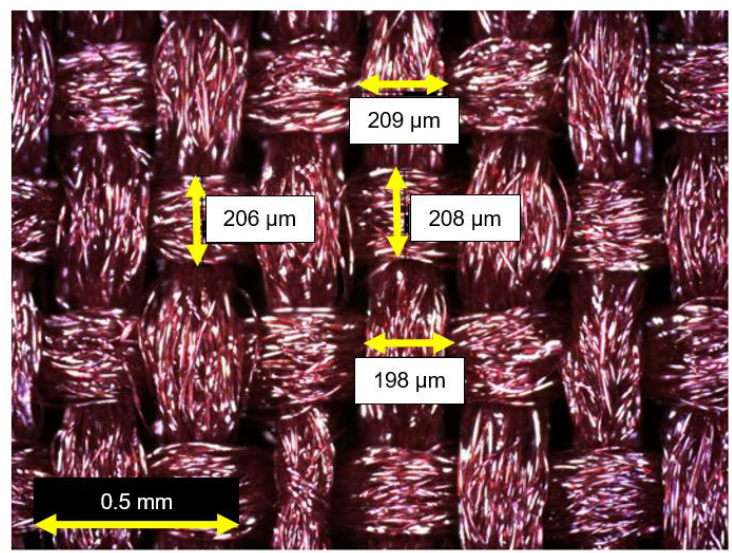
Figure 5. Polyrester textile morphology.